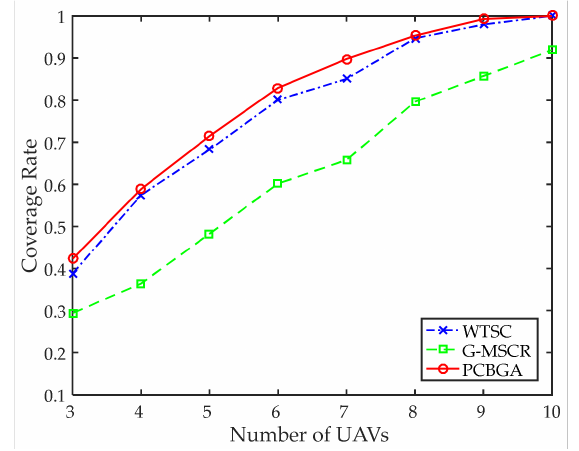
Figure 7. Comparison of the coverage rate with the increase of